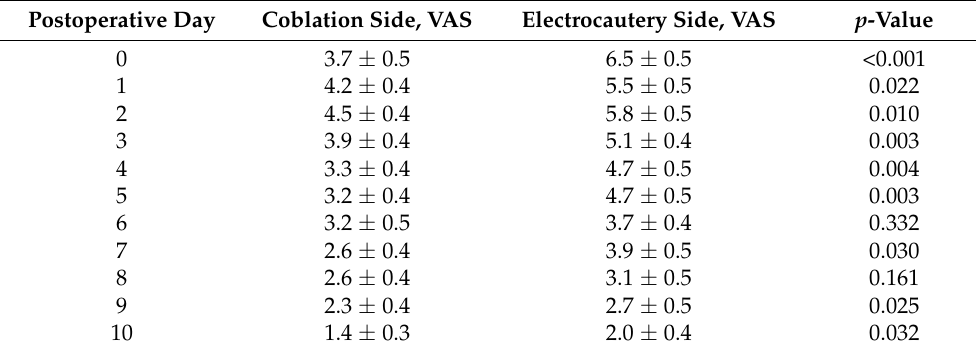
Table 3. Daily pain scores, visual analog scale, on the coblation and electrocautery tonsillectomy sides ( n = 30).